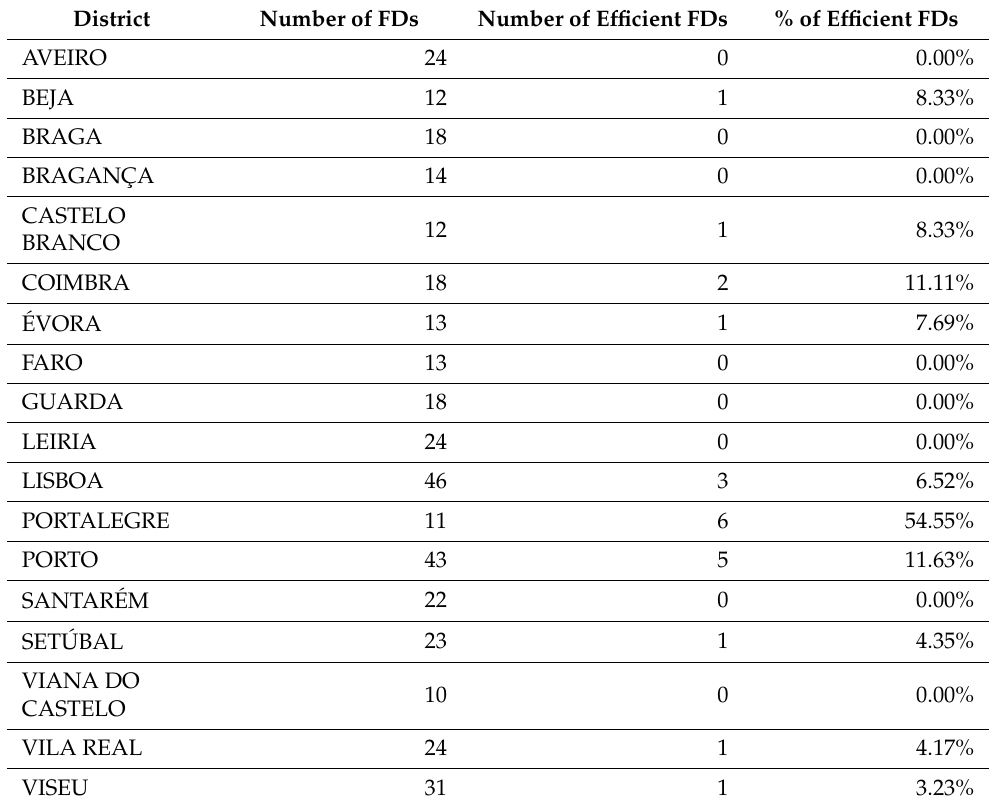
Table 4. Number and percentage of efficient FDs in each of the 18 districts of Portugal (except islands). District Number of FDs Number of Efficient FDs % of Efficient